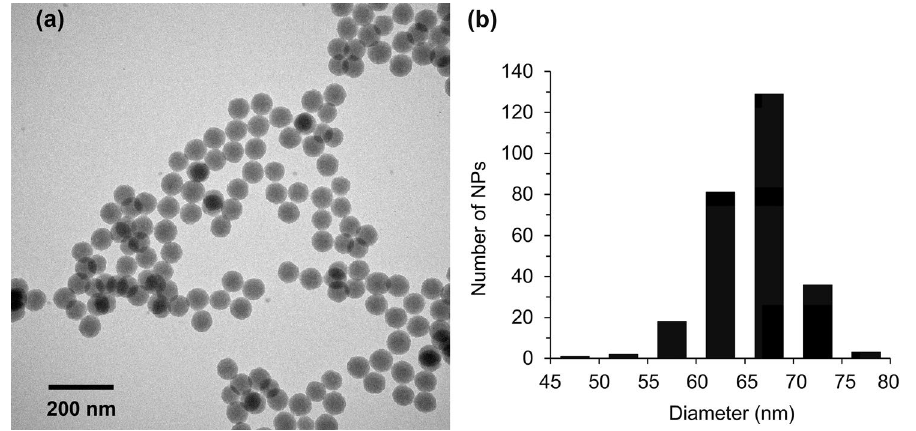
Figure 1. ( a ) A transmission electron microscope (TEM) image at 100,000 × magnification showing the spherical shape of FSNPs and ( b ) size distribution of FSNPs measured from TEM images using ImageJ software (version 1.53o, NIH,